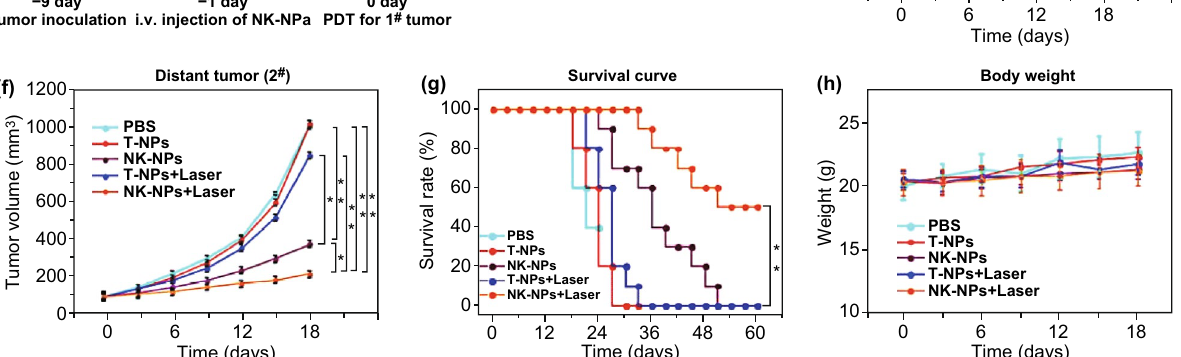
Fig. 10 a ROS production in cells exposed to T‑ or NK‑membrane NPs following 660 nm irradiation (100 mW cm −2 ) was assessed using the fluorescent DCFH‑DA indicator. b Flow cytometric assessment of apoptotic induction in irradiated cells exposed to T‑ and NK‑NPs. c Western blotting‑mediated measurement of apoptosis‑associated proteins in response to NK‑NP + PDT treatment. d Overview of the study experimental design, with a dual 4T1 tumor implant model in which primary tumors on the right side received PDT, whereas distal tumors on the left side did not. e Primary tumor growth. f Distal tumor growth. g Morbidity‑free survival of differently treated mice. h Changes in body weight of differ‑ ently treated mice. ( n = 10). (* p < 0.05, ** p < 0.01). Adapted from Ref. [128] with